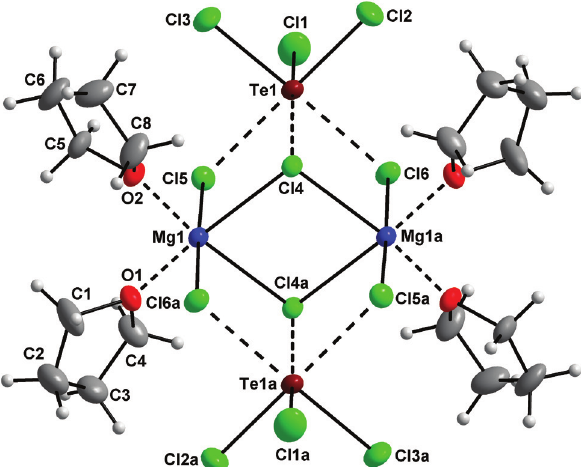
Mg ( μ -Cl )( μ -Cl )Cl ·4 2 2 3 2 2 4 6